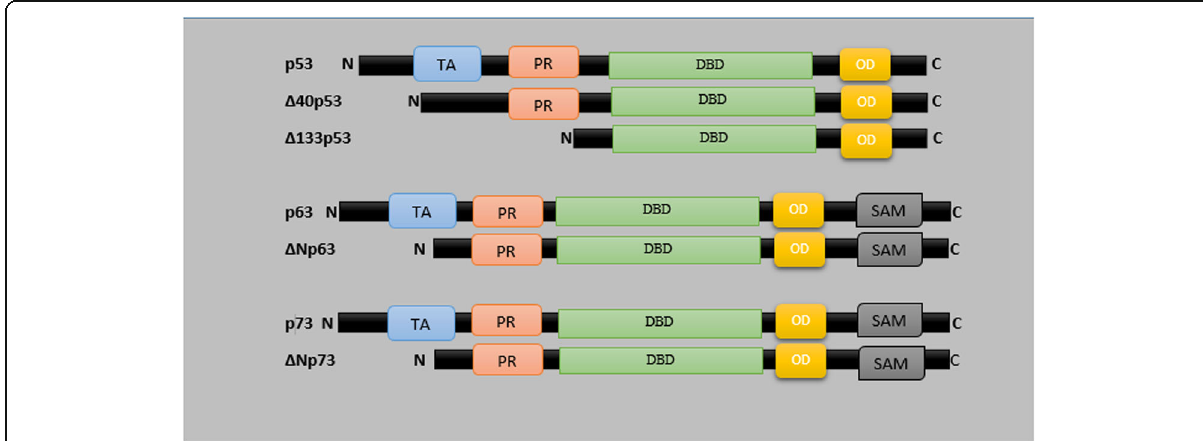
Fig. 1 The most important functional domains of the P53 protein family